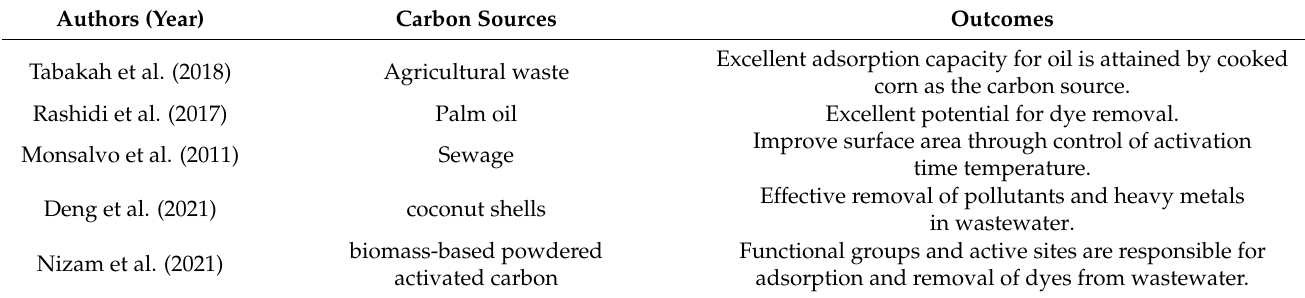
Table 5. Recent studies on modified activated carbons for watstewater